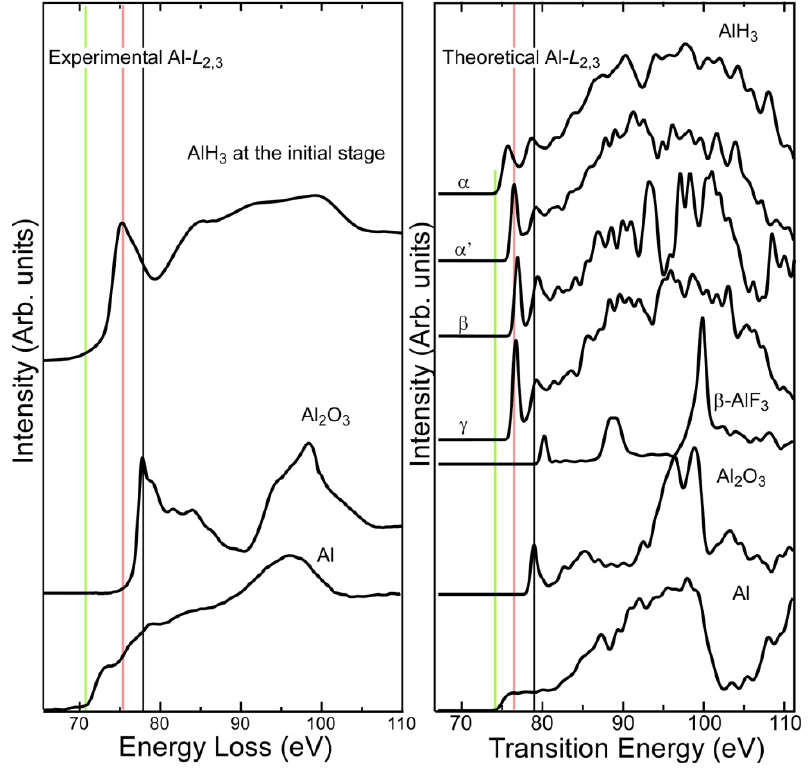
Figure 1. Experimental ( a ) and theoretical ( b ) Al- L (ELNES) of AlH and reference compounds. The vertical green, red, and black lines indicate 3 the energy positions of the onset of metallic Al spectrum, the first peak of AlH peak of Al O , 2 3